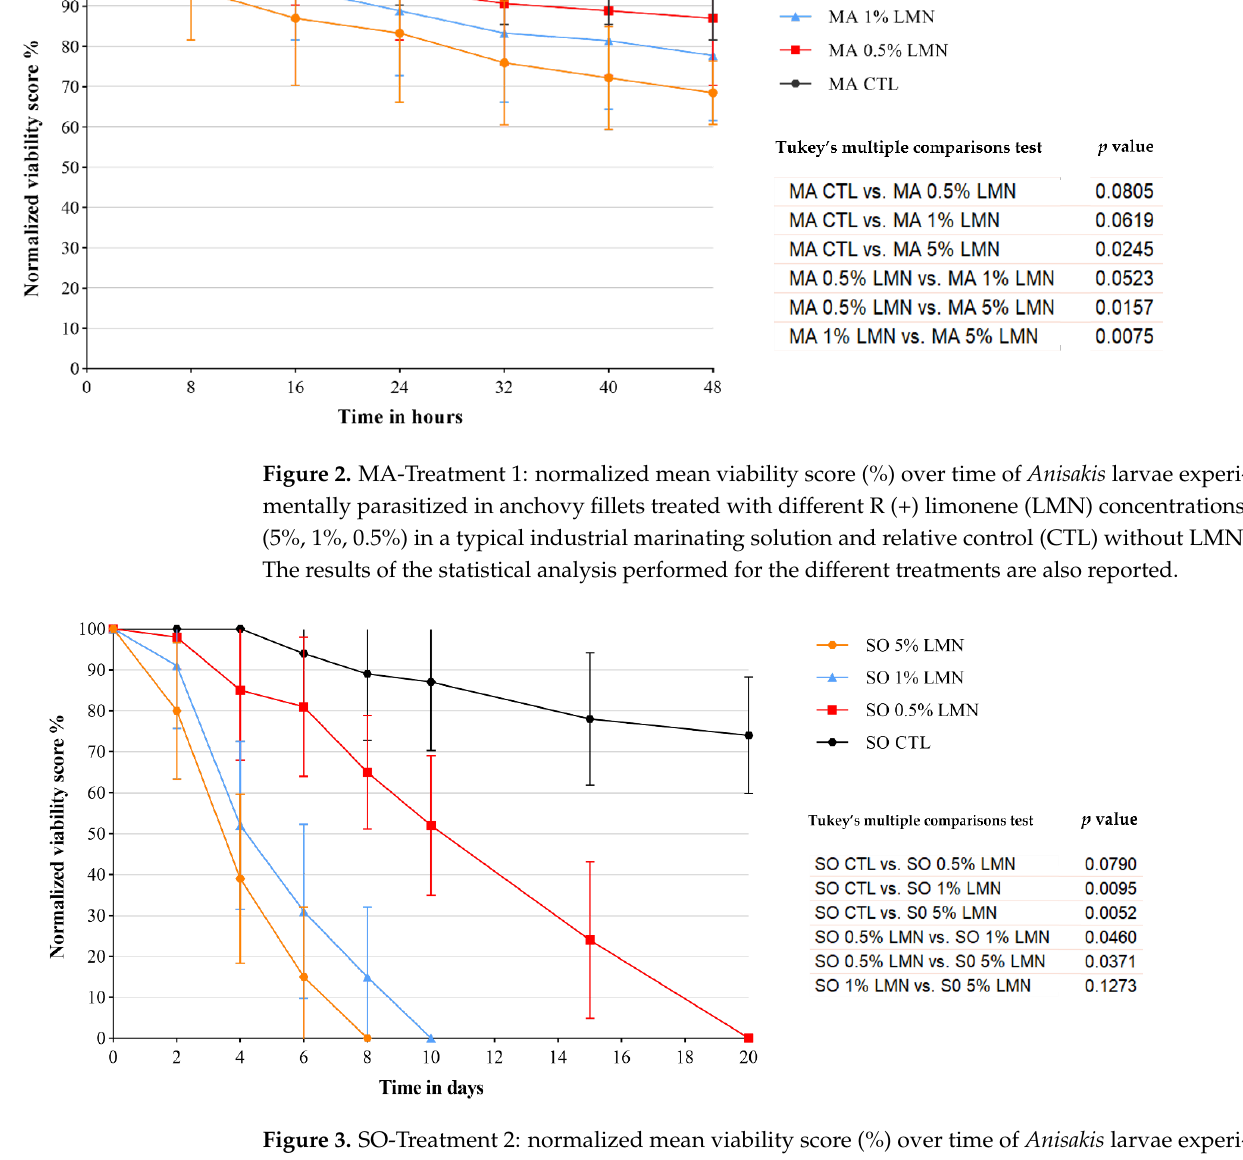
Figure 2. MA-Treatment 1: normalized mean viability score (%) over time of Anisakis larvae experi- mentally parasitized in anchovy fillets treated with different R (+) limonene (LMN) concentrations (5%, 1%, 0.5%) in a typical industrial marinating solution and relative control (CTL) without LMN. The results of the statistical analysis performed for the different treatments are also reported.